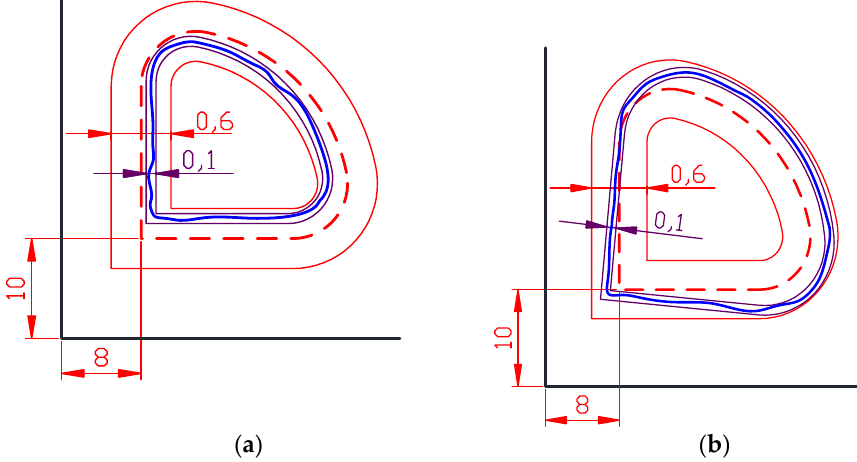
Figure 22. Surface profile tolerance zone (T = 0.6 mm) fixed with respect to datum system A|B|C. ( a ) One of the numerous dynamic tolerance zones (T = 0.1 mm); ( b ) another of the numerous dynamic tolerance zones (T = 0.1 mm). The dynamic surface profile tolerance zones are free to translate, rotate and uniformly expand or contract.